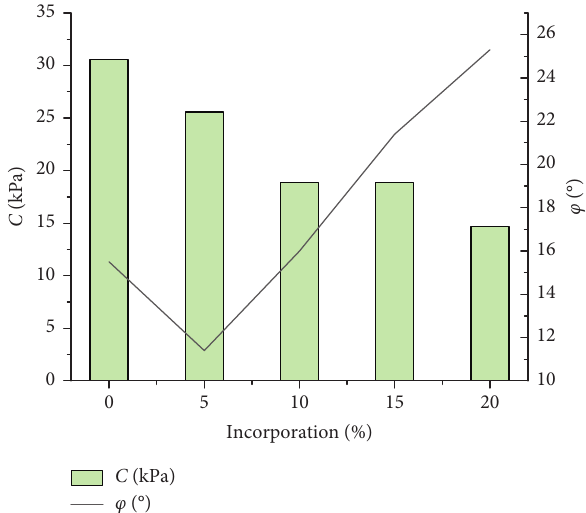
Figure 3: Cohesion ( C ) and internal friction angles ( φ ) of red clay samples doped with different contents of calcium carbonate.